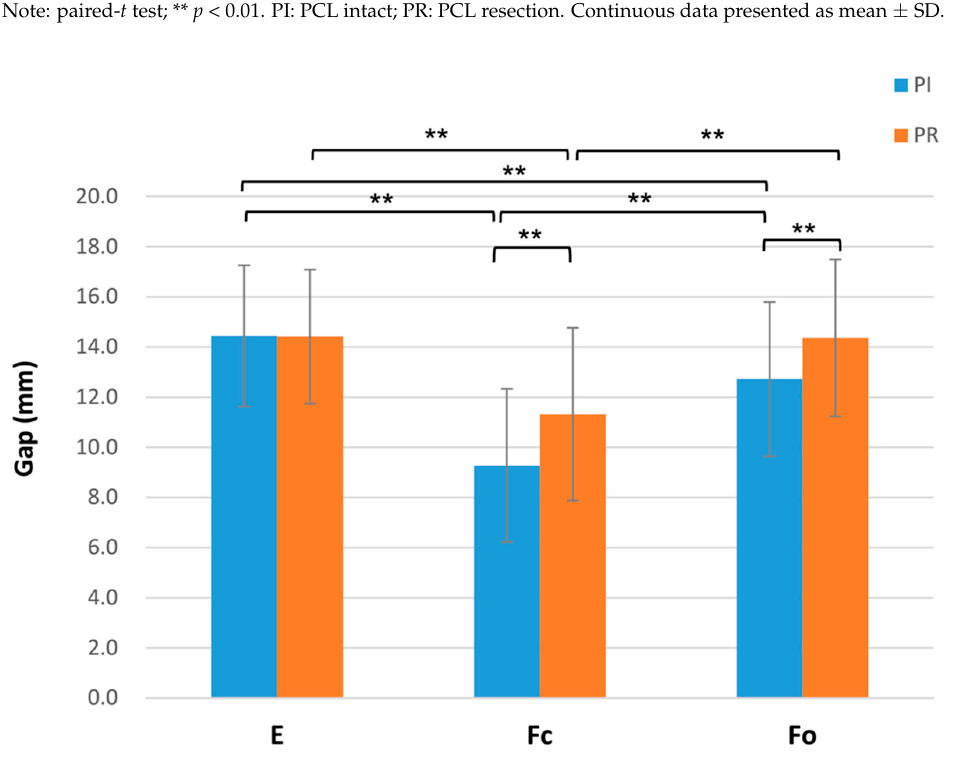
Figure 4. Comparisons of the extension gap (E), flexion gap in closed-chain (Fc), and open-chain (Fo) before and after PCL resection. Paired-t test; ** p <